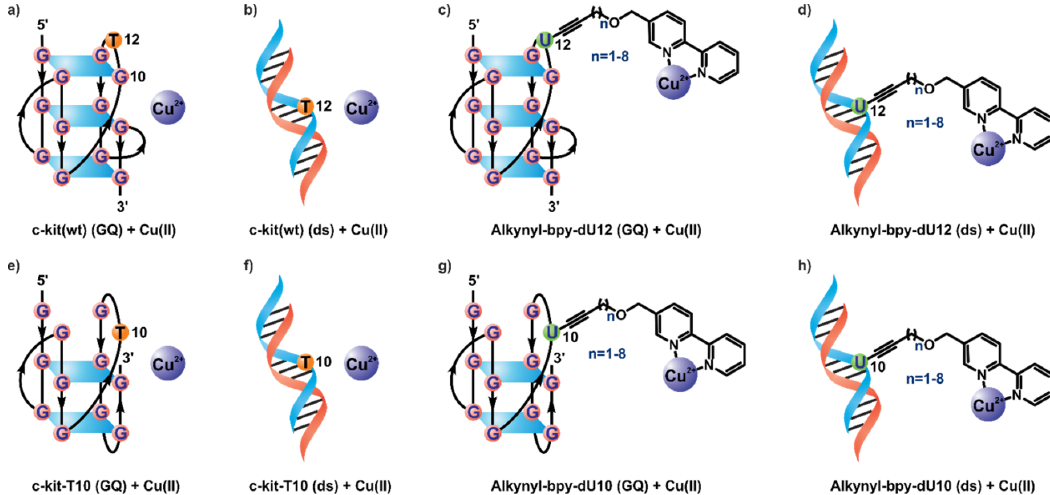
Figure 1. Folding of different G-quadruplex and dsDNA sequences in the presence of Cu(II). ( a ) Folding of (GQ) c-kit(wt) DNA as observed [63,64]. ( b – h ) Schematic representation of hypothetical folding and metal binding of (ds) c-kit(wt) ( b ), (GQ) dU12-modified DNA ( c ), (ds) dU12-modified DNA ( d ), (GQ) c-kit-T10 DNA ( e ), (ds) c-kit-T10 DNA ( f ), (GQ) dU10-modified DNA ( g ), and (ds) dU10-modified DNA ( h ). All double-stranded (ds) samples included 1 equivalent corresponding complementary DNA strand.